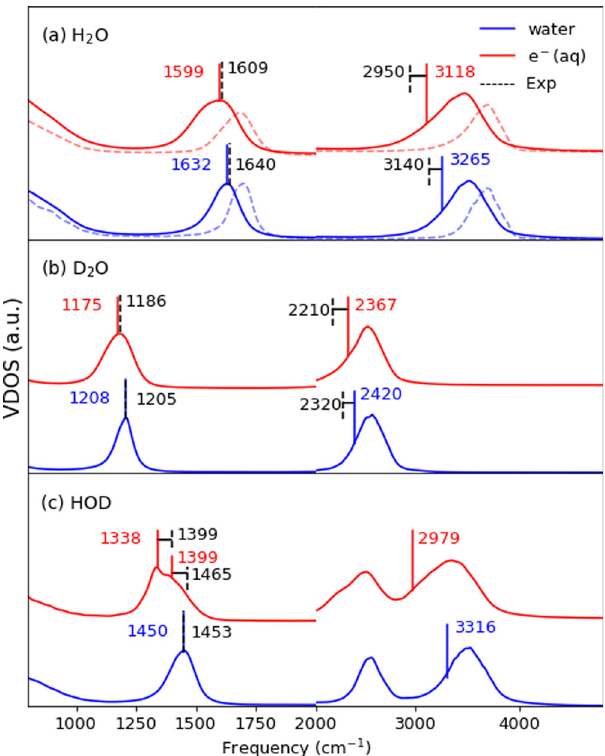
Fig. 3 Vibrational density of states (VDOS). a H 2 O; b D 2 O; c HOD. Neat water (blue) and of the fi rst coordination shell of a solvated electron (red), computed from the velocity autocorrelation function of atoms from TRPMD, or classical MD (dashed lines in panel ( a )) simulations. The spectra are averaged over 30 independent 10-ps-long trajectories. The bending mode peak positions and the stretching peak half-maximum position at stretch mode are marked by vertical lines, to facilitate direct comparison with experiments, indicated by black dashed lines 33